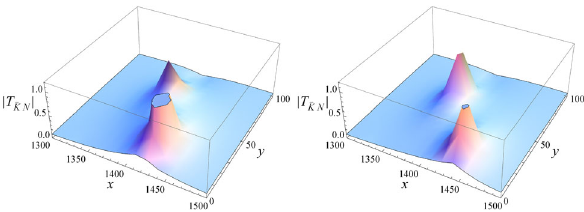
(cid:29) (cid:29) (cid:29) in the second Rie- (cid:29) T ¯ KN √ s = x + iy ) for the inter-